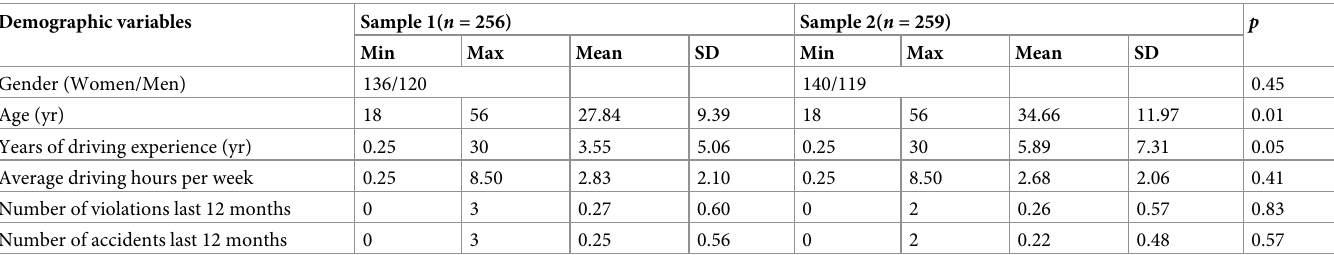
Table 1. Demographic